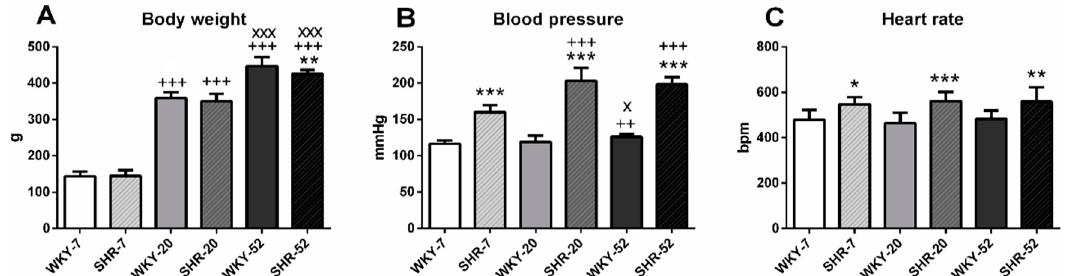
Figure 1. Basic characteristics of experimental animals: body weight ( A ), systolic blood pressure ( B ), and heart rate ( C ). The data are presented as means ± SD. Statistical significance: * p < 0.05, ** p < 0.01, *** p < 0.001 between WKY and SHR at the same age (WKY-7 vs. SHR-7, WKY-20 vs. SHR-20 and WKY-52 vs. SHR-52), ++ p < 0.01, +++ p < 0.001 vs. 7-week group of the same phenotype (WKY-20 vs. WKY-7, SHR-20 vs. SHR-7, WKY-52 vs. WKY-7 and SHR-52 vs. SHR-7), X p < 0.05, XXX p < 0.001 vs. 20- week group of the same phenotype (WKY-52 vs. WKY-20 and SHR-52 vs. SHR-20). WKY—Wistar-